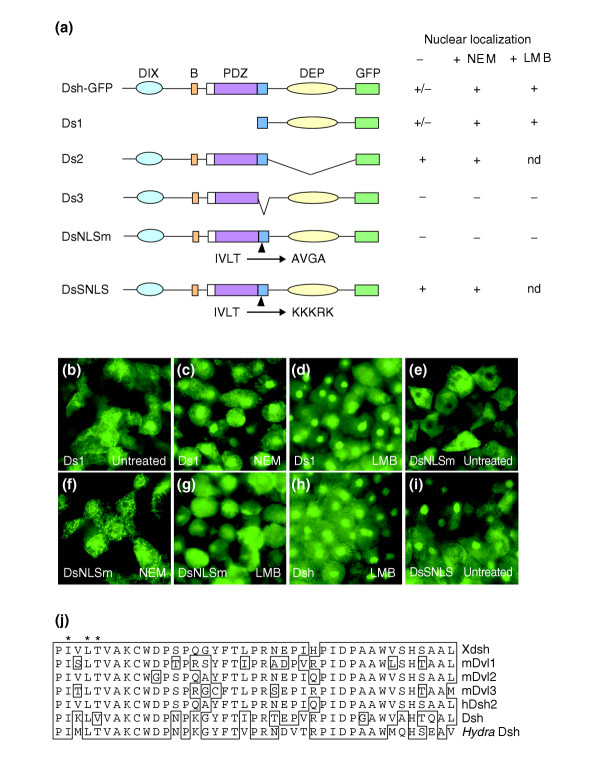
Mapping nuclear localization signals in Dsh. (a) The Dsh constructs used to study nuclear transport and their localization to the nucleus after NEM or LMB treatment; the DIX, PDZ and DEP domains are shown as in Figure 1a; B is the basic region and nd denotes not done. (b-i) Subcellular localization of Dsh-GFP constructs in the absence or presence of NEM or LMB. Embryos were injected with 0.5 ng of each mRNA, and GFP analysis was carried out as in Figure 1b-d. (b-d) Ds1, (e-g) DsNLSm, (h) Dsh, (i) DsSNLS. (b,e,i) no NEM treatment; (c,f) after NEM treatment; (d,g,h) after LMB treatment. (j) Comparison of conserved amino-acid sequences that are required for Dsh nuclear localization; X denotes the Xenopus protein, m the mouse and h the human. Amino-acid residues mutated in DsNLSm are indicated by asterisks.